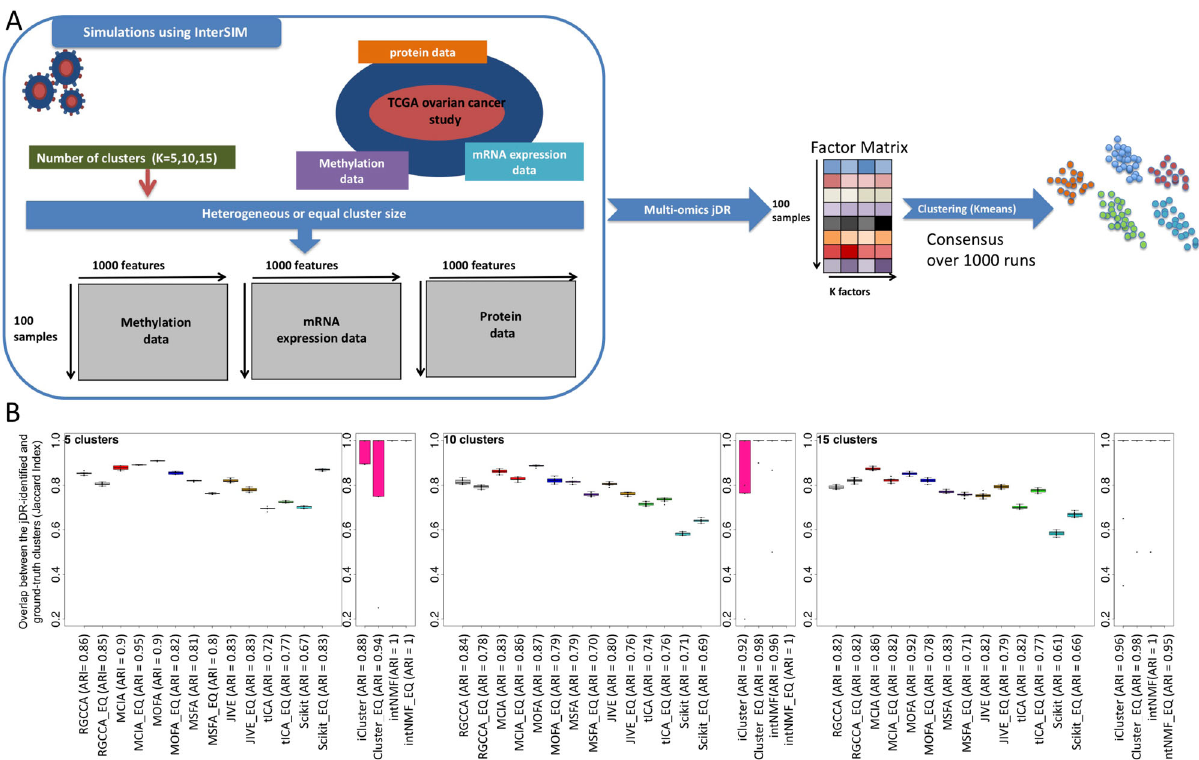
Fig. 3 jDR clustering of simulated multiomics datasets. a Work fl ow of the simulation sub-benchmark from the data generation with interSIM, to the jDR output and its clustering based on k-means. b Boxplots of the Jaccard Index computed between the clusters identi fi ed by the different jDR methods and the ground-truth clusters imposed on the simulated data (for 5, 10, and 15 imposed clusters). For each method (e.g., RGCCA), performances on heterogeneous and equally sized clusters are reported (denoted as RGCCA and RGCCA_EQ, respectively). The corresponding Adjusted Rand Index (ARI) values are further reported near to the name of the jDR methods along the x -axis. The number of samples here considered is 100 and the results are obtained over 1000 independent runs of k-means clustering. Data are presented as mean values ± sd, whiskers denote max, and min